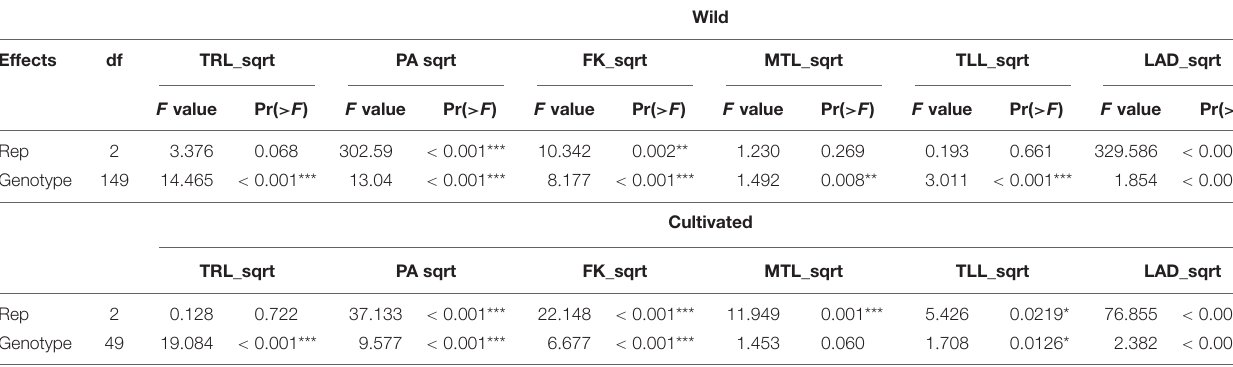
TABLE 1 | Analysis of variance for the wild ( n = 150) and cultivated soybean ( n = 50).